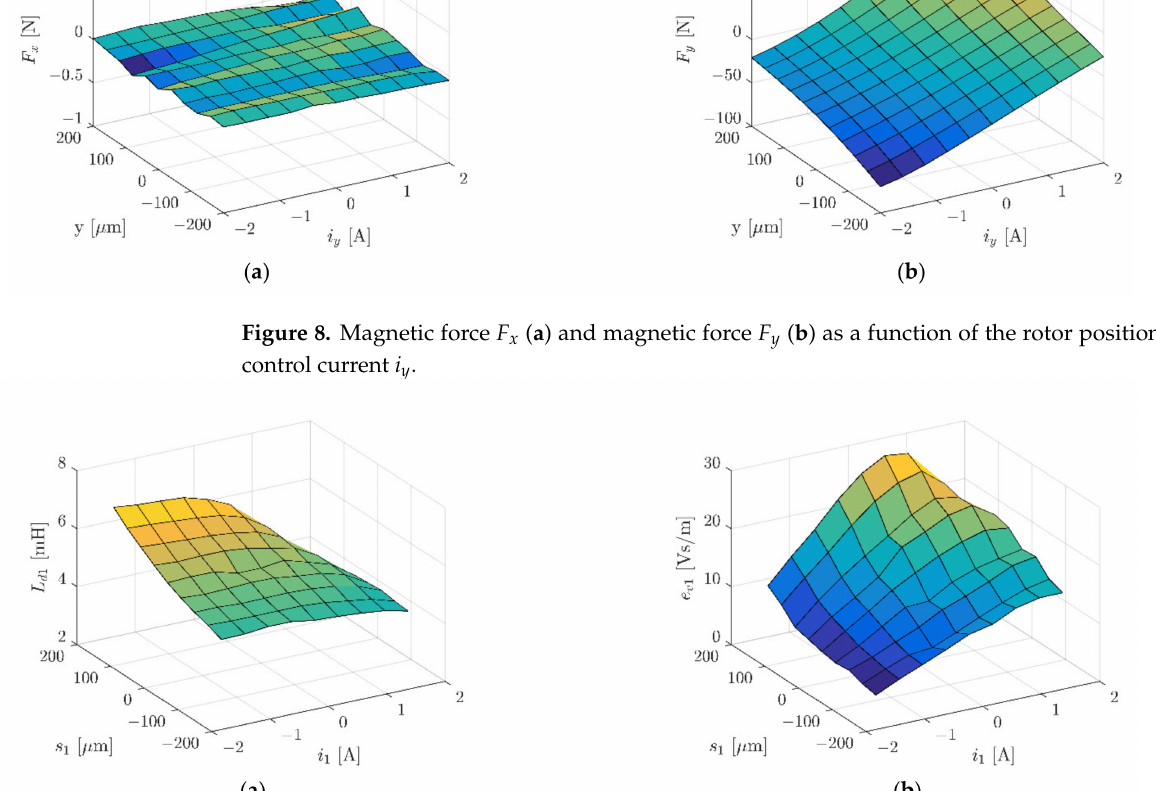
Figure 9. Dynamic inductance L d 1 ( a ) and velocity-induced voltage e v 1 ( b ) as a function of the rotor position s 1 and winding current i 1